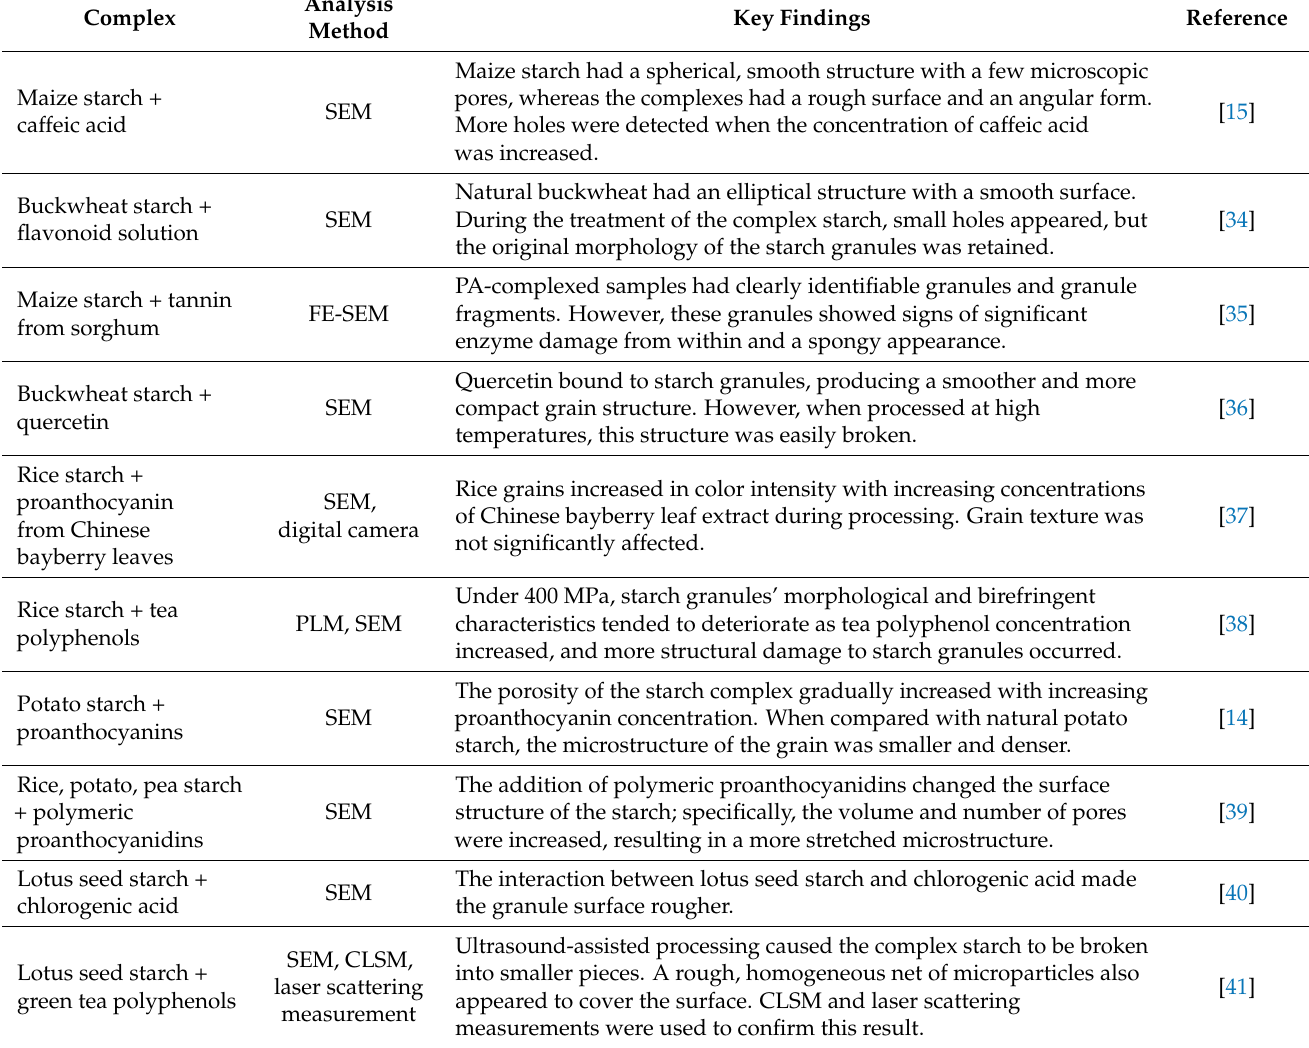
Table 1. Recent studies of the effect of polyphenol–starch complexation on starch morphological properties. Key Findings